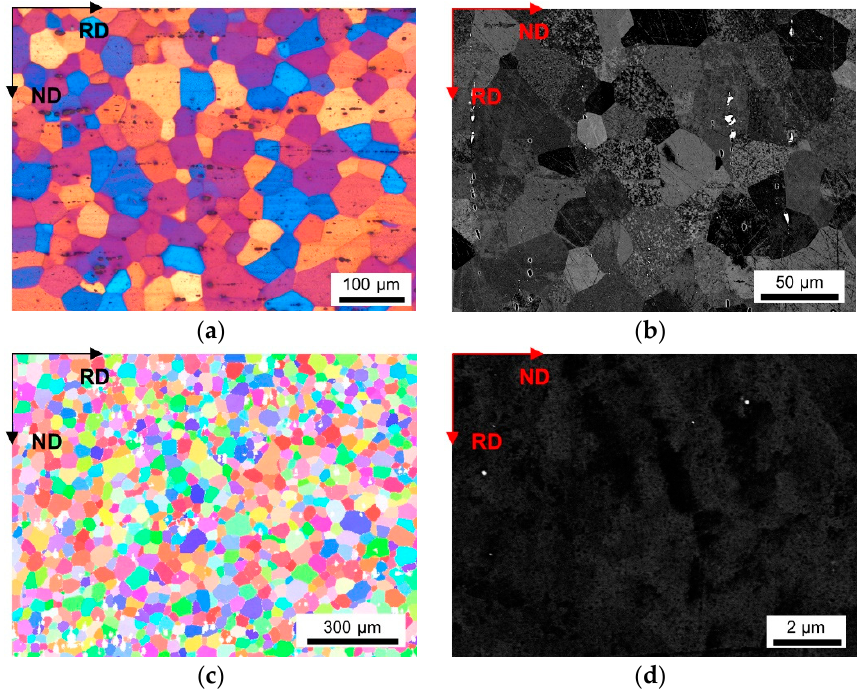
Figure A1. Microstructure of the soft annealed LFe-LMn cast under S-C condition, homogenized at 500 °C and cold rolled to a CRD of 35%. ( a ) LOM. ( b ) BSE image. ( c ) EBSD IPF map in RD–ND plane. ( d ) BSE micrograph showing dispersoids.